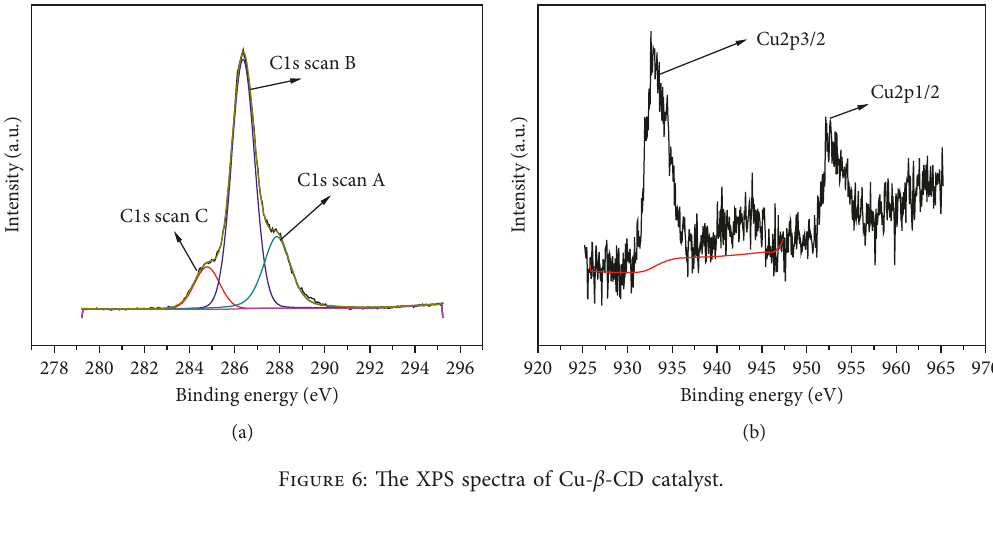
Figure 6: The XPS spectra of Cu- β -CD catalyst.